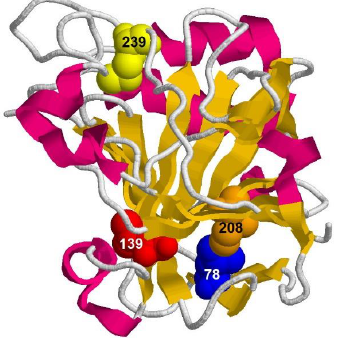
Figure 2. Three-dimensional model of bovine carbonic anhydrase II (PDB: 1v9e). The substituted amino acid residues are shown in space-filled representation. Amino acids located in the structural elements of the protein, which are formed at different stages of folding of carbonic anhydrase, were selected for replacement. As we showed earlier [17], the protein structure in the region of I208 and L139 is formed first, and the loop in the region of L78 is formed at the last stage of carbonic anhydrase folding.